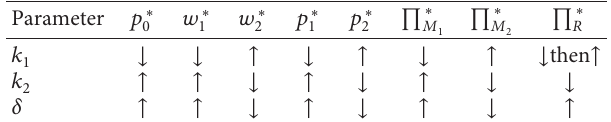
Table 5: Sensitivity analysis of optimal price and profit under different